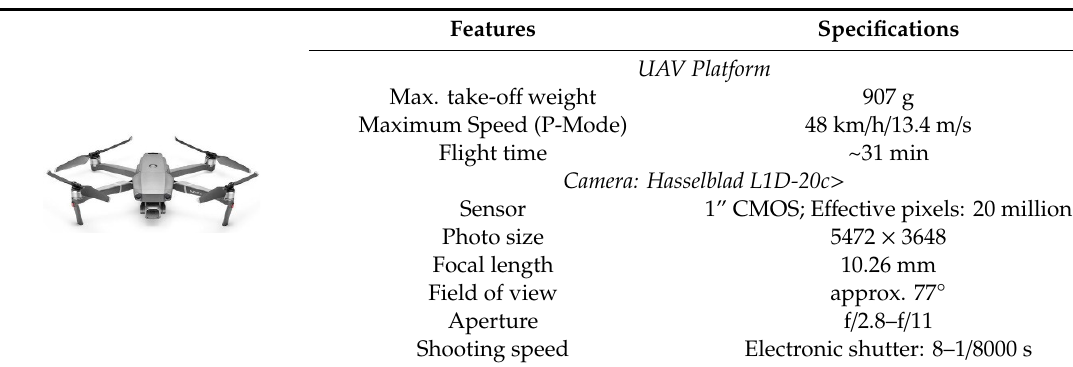
Table 2. Features of the DJI Mavic 2 Pro.